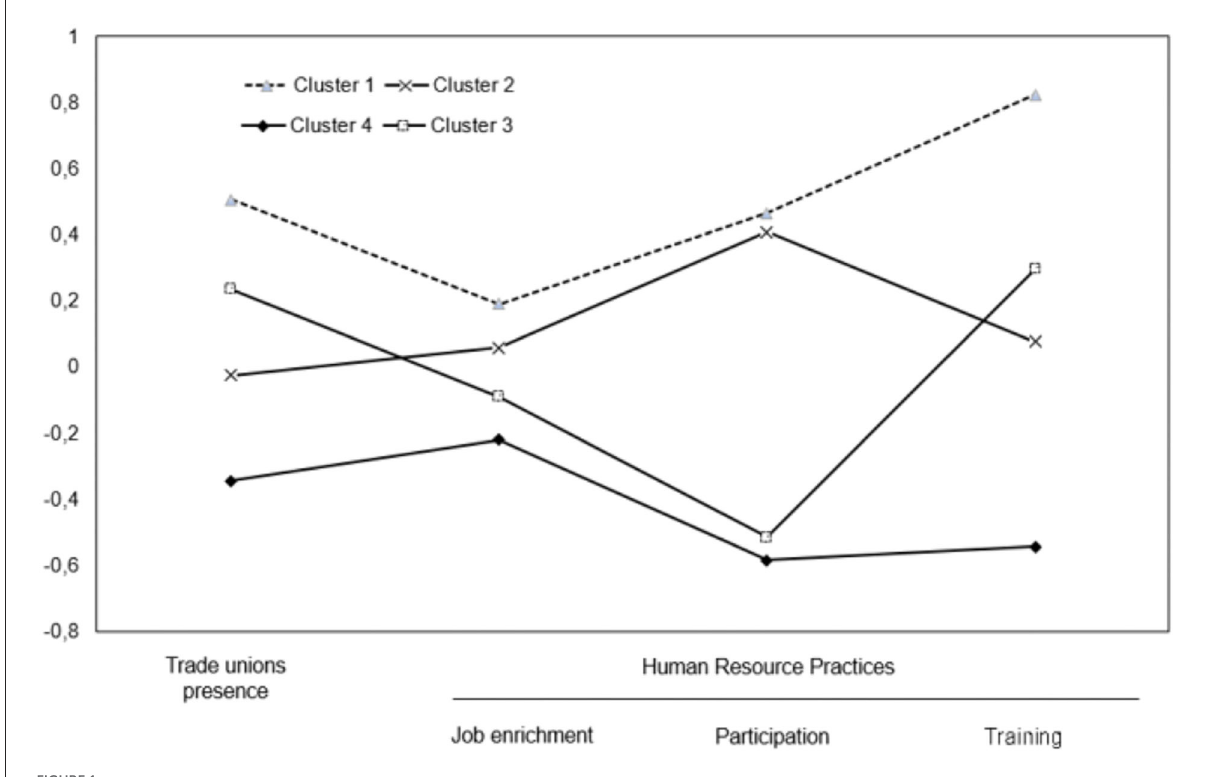
FIGURE1 Identified profiles in Europe private